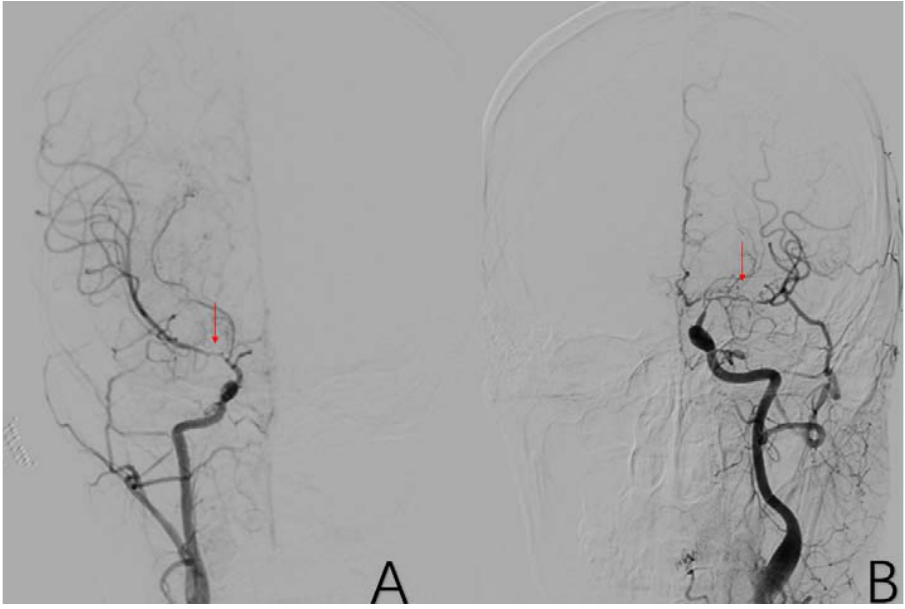
Figure 6. ( A ) is a 45-year-old female. This is a DSA image of his right common carotid artery. ( B ) is a 48-year-old male. This is a DSA image of his left common carotid artery. The red arrows show the location of M1 stenosis.